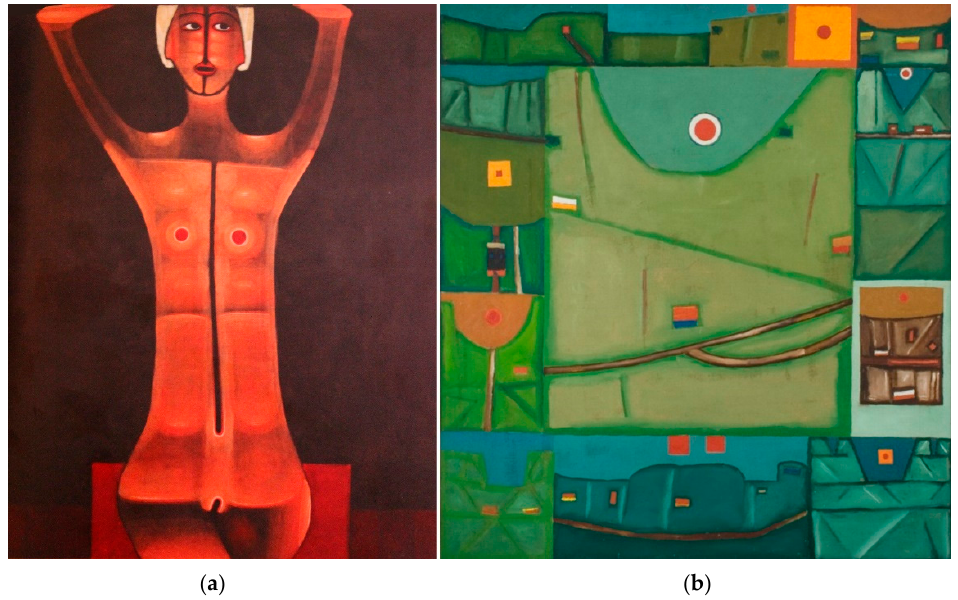
Figure 4. Jerzy Nowosielski: ( a ) nude in a bonnet, 1976, oil on canvas. National Museum in Wrocław. Photography by M. Gardulski/Galeria Starmach. Reproduced with permission. ( b ) Sunrise in the Bieszczady Mountains, 1963, oil on canvas. Zach ę ta Gallery in Warsaw. Photography by M. Gardulski/Galeria Starmach. Reproduced with permission.